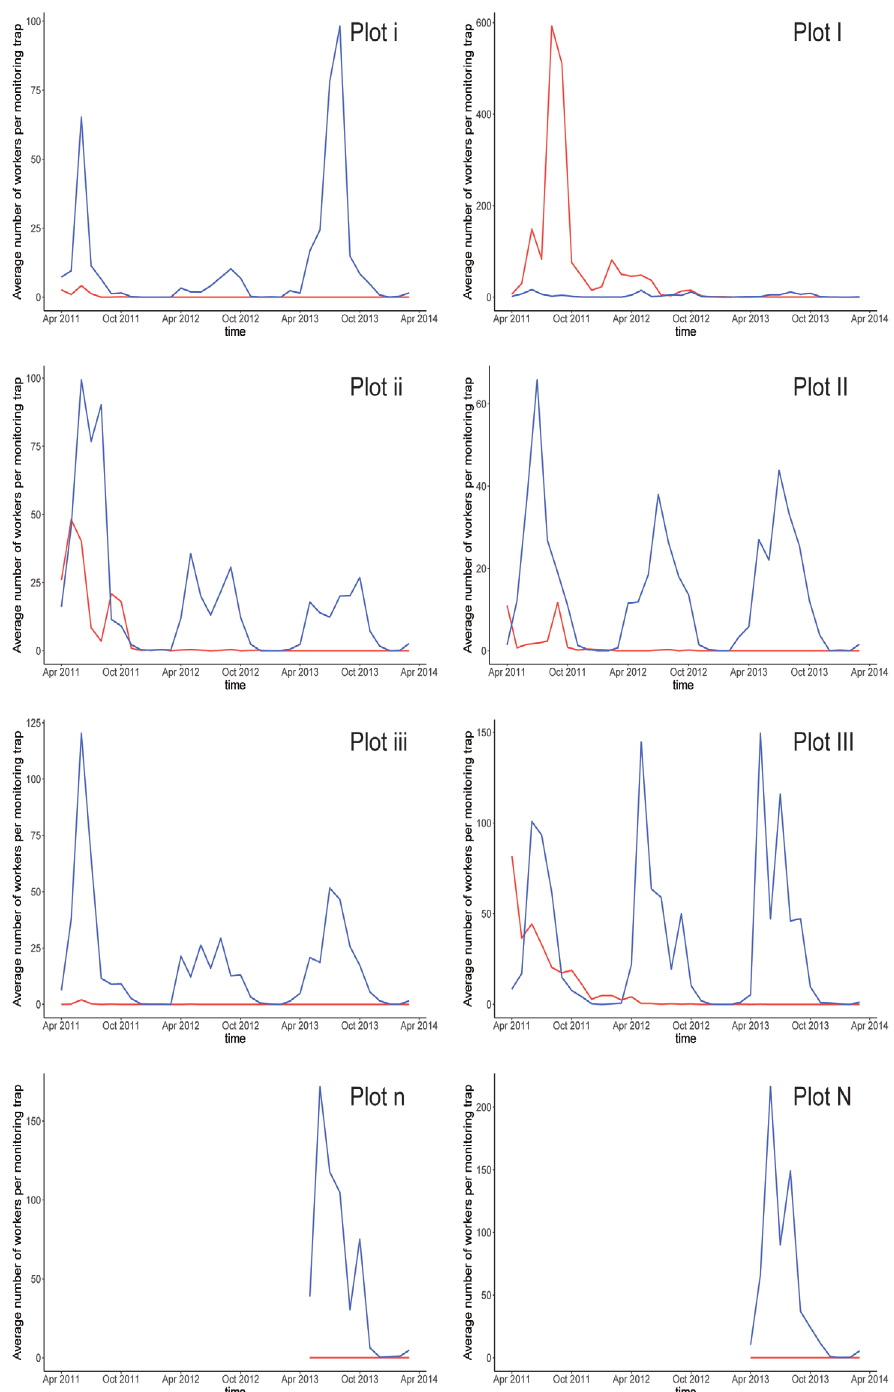
Fig 3. Mean total number of Linepithema humile (red line) and non-target ants (blue line) per trap by month in plots invaded by L. humile (i–iii, I–III) and untreated, non-invaded plots (n,